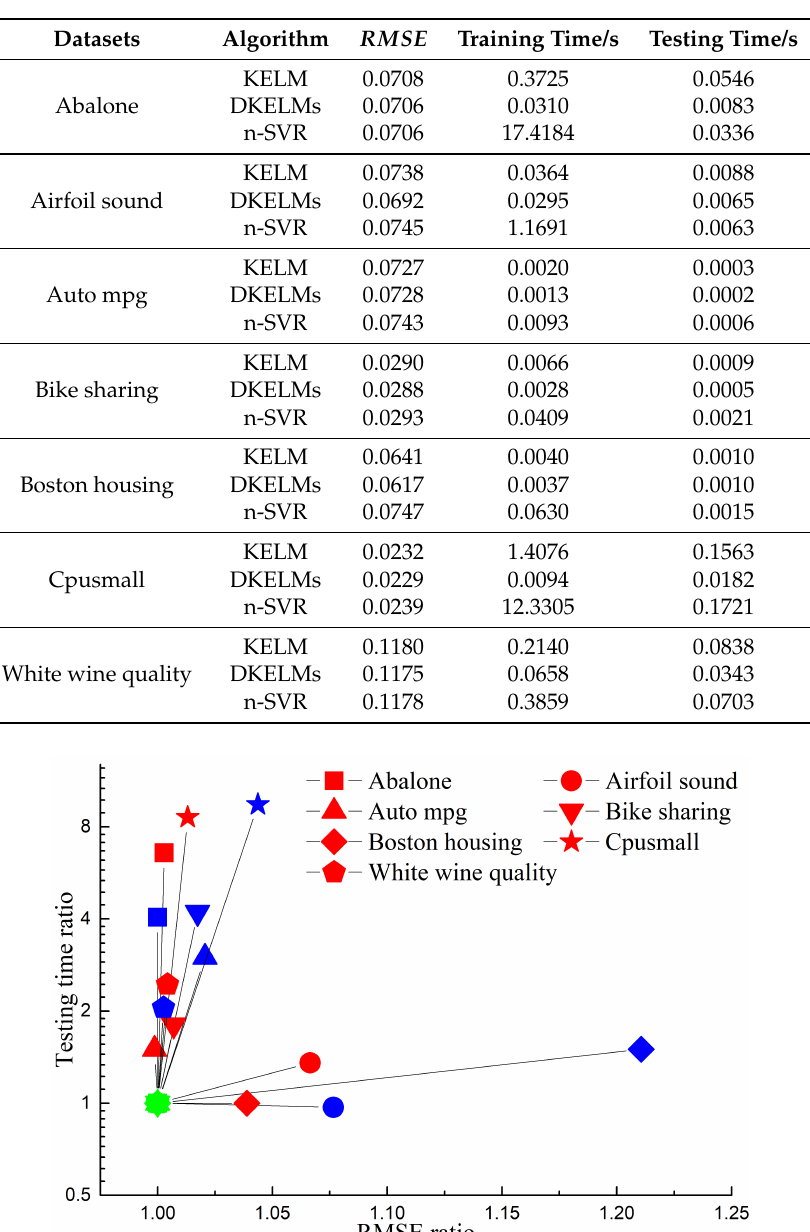
Table 2. Performance of distributed KELM on regression benchmark datasets.